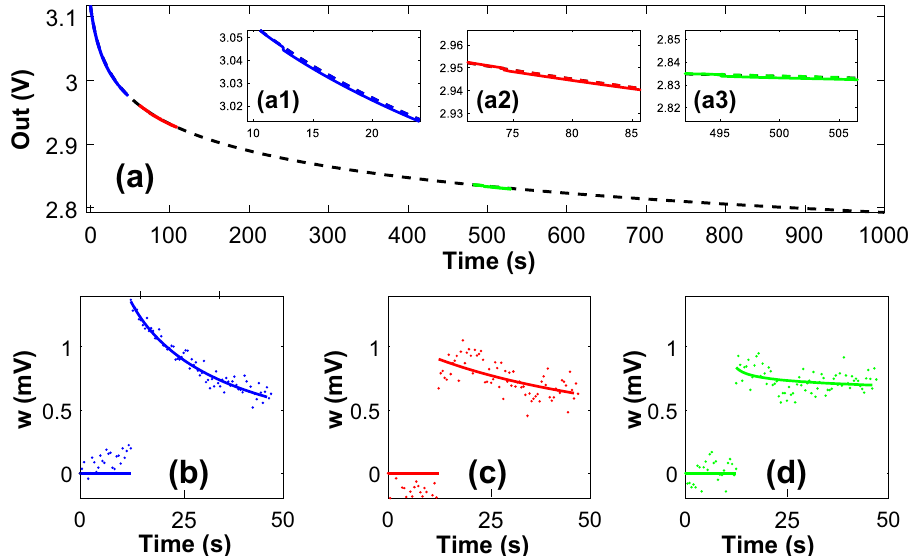
Fig. 2 FN-DAM plasticity under different operating regions. a W S (solid line) and W R (dashed line) response under three different operating regimes (zoomed insets: a1, a2, a3) determined by FN-DAM initialization voltage. b – d FN-DAM response ( w ) calculated as difference between W S and W R voltage values in the three regimes demonstrating different plasticity. Dots are measured datapoints while lines correspond to fi t to the